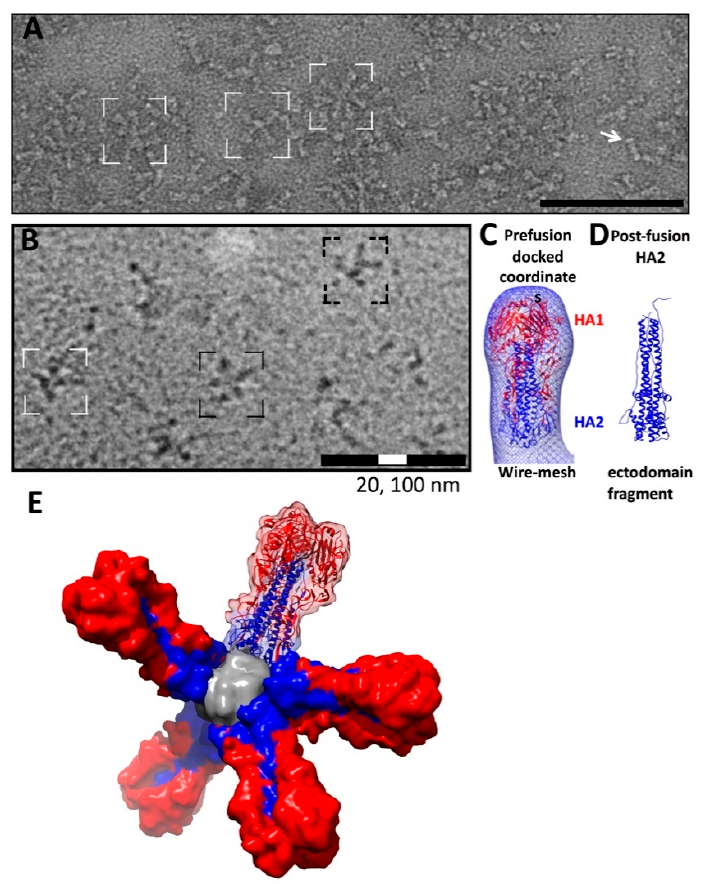
Figure 4. Characterization of HA complexes used as vaccine immunogens by electron microscopy. ( A ) molecular complexes imaged by negative staining EM for a commercial influenza HA subunit-based vaccine for the 2017–2018 influenza season (Fluzone). Density contrast is represented as white. Brackets denote some select HA complexes. An arrow denotes an HA molecule. Scale bar, 100 nm; ( B ) HA complexes of recombinant H7 HA imaged by cryo-electron microscopy. Density contrast is represented as black. Brackets denote some select HA complexes. Scale bars, 100 nm and 20 nm; ( C ) 3D map of H7 HA derived from cryo-EM images of HA complexes. The map is shown as a wire mesh with docked H7 ectodomain coordinates (PDB 4DJ6) in a pre-fusion state and compared with ( D ) post-fusion HA coordinates (PDB 1QU1). HA1 is red with HA2 in blue. ( E ) 3D model of a HA-complex. HA molecules are from coordinates (3LZG) and are shown as molecular surfaces. One constituent HA molecule is shown as a ribbon diagram with a transparent surface. Panels ( A ) and ( E ) are originals and panels ( B – D ) were adapted from McCraw et al. [39].